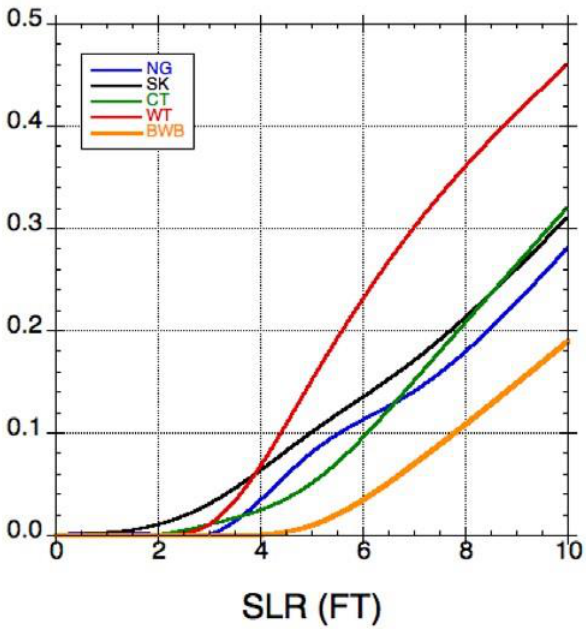
Figure 11. Fraction of houses experiencing some damage (Figure 9) predicted to be under the mean sea level (MSL) assuming the most likely scenario for any SLR case between 0 and 10 ft for towns of Narragansett (NG), South Kingstown (SK), Charlestown (CT), Westerly (WT), and Barrington, Warren, and Bristol (BWB).